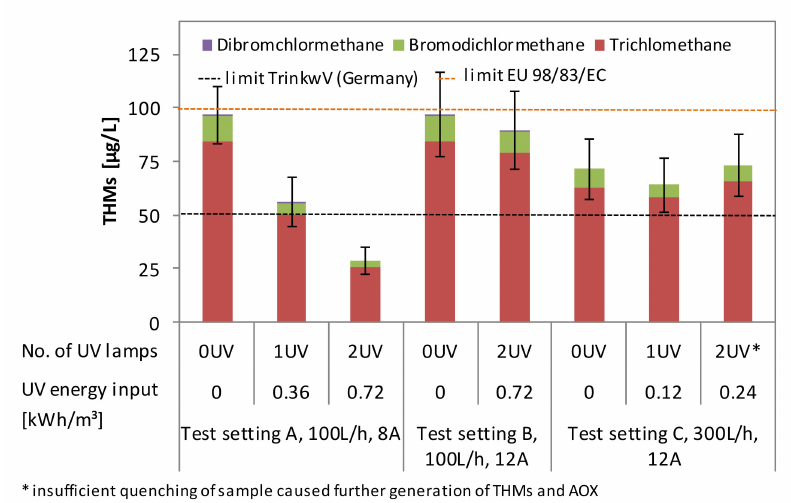
Figure 12. THM concentrations measured in three di ff erent settings during field tests with Elbe river